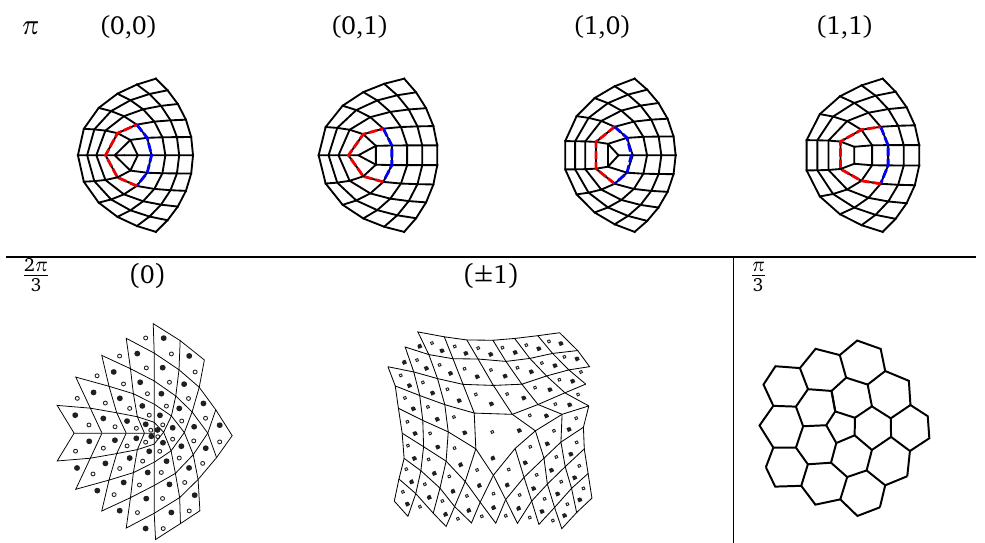
Figure 2: Disclinations in twofold-, threefold-, and sixfold-symmetric lattices: π disclinations in twofold-symmetric lattices come in four types ( T distinguished by the parity of their translation holonomy T tion holonomy is indicated by the dashed lines, where red (blue) lines are transla- tions in the x ( y ) direction of the local coordinate system. The unit cells of three- fold symmetric lattice are parallelograms composed of two equilateral triangles (see Fig. 5). For sixfold symmetric lattices, we choose a hexagonal primitive unit cell. For a threefold-symmetric lattice, there are three types of 2 π/ 3-disclinations. Different threefold rotation centers within the unit cell are denoted by filled and hollow dots. The two types ( ± 1 ) of 2 π/ 3-disclinations differ by exchanging the filled-dot